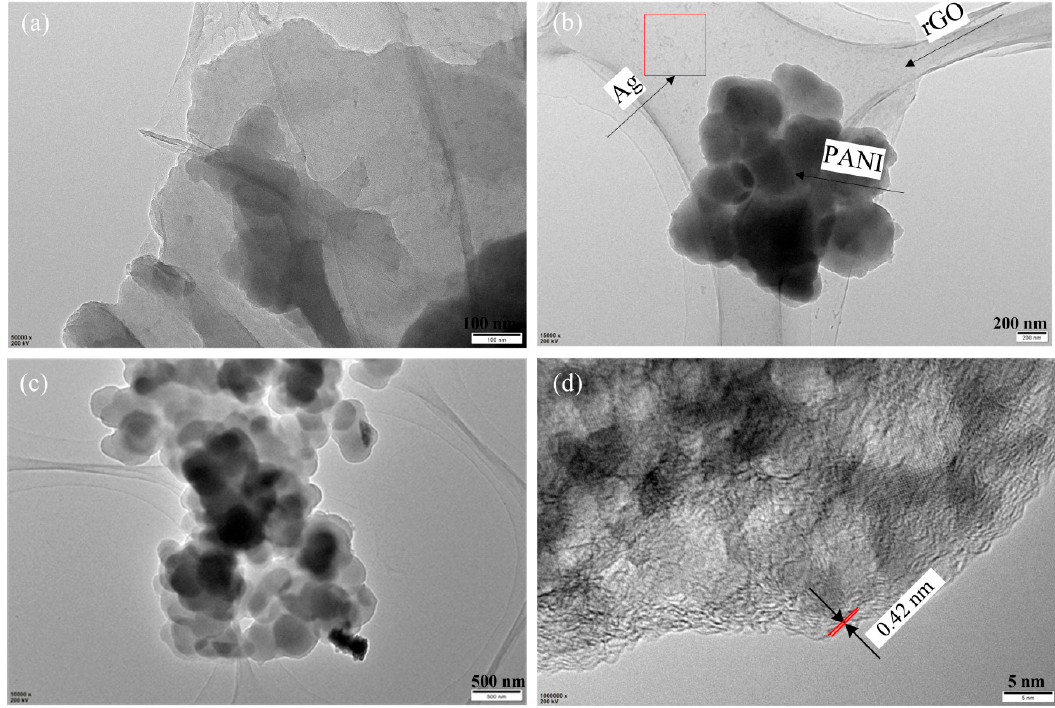
Figure 4. TEM images of PANI / rGO / Ag / FP electrode. ( a ) TEM image of rGO; ( b ) TEM image of PANI / rGO / Ag; ( c ) TEM image of PANI / rGO; ( d ) TEM image of rGO.